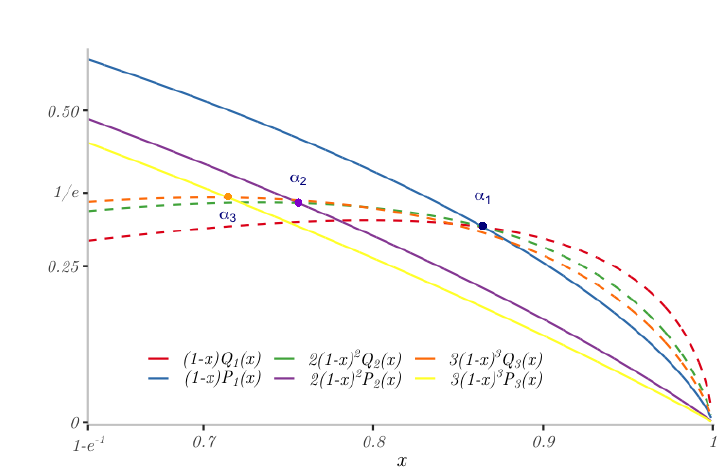
Figure 4. next and bygone curves for k =